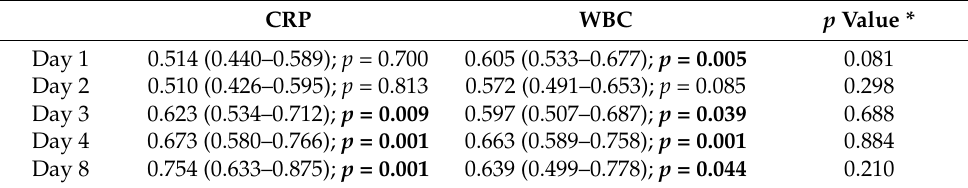
Figure 1. Distribution of CRP and WBC counts among survivors and non-survivors during the first 8 days after admission (i.e., on days 1, 2, 3, 4, and 8). Data is presented as median. As illustrated in Table 4, the prognostic AUCs of CRP to predict all-cause mortality at 30 days were poor for day 1 (0.514; p = 0.700) and day 2 (AUC 0.510; p = 0.813), but improved on day 3 (AUC 0.623; p = 0.009), day 4 (AUC 0.673; p = 0.001), and day 8 (AUC 0.754; p = 0.001). In line, the WBC count displayed reliable discrimination for 30-day all-cause mortality on day 1 (AUC 0.605; p = 0.005), but poor discrimination on day 2 (AUC 0.572; p = 0.085) and day 3 (AUC 0.597; 0.039). At 30 days, all-cause mortality occurred in 59% of patients with WBC counts > 10 × 10 6 /mL on day 1 and in 40% of the patients with WBC counts ≤ 10 × 10 6 /mL (log-rank p = 0.036; HR = 1.643; 95% CI 1.010–2.672; p = 0.045) (Figure 2). Table 4. C-statistics to discriminate 30-day all-cause mortality by CRP and WBC.